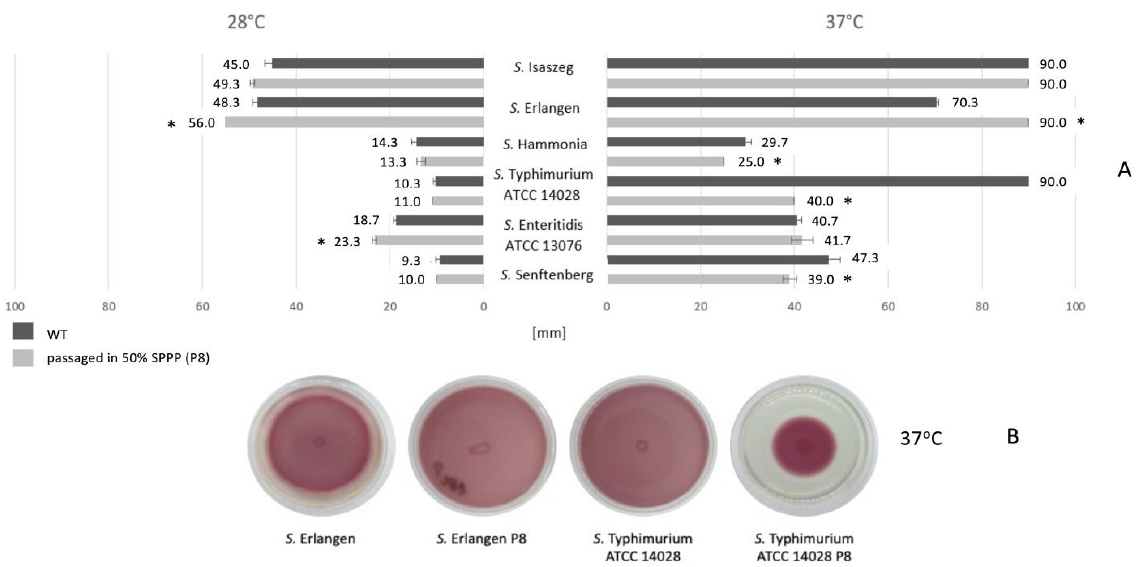
Figure 8. Swimming motility assay. Definitions of abbreviations: ( A ) — the average (n = 3) diameter of bacterial cultures (WT and P8) grown on 0.3% soft agar supplemented with TTC at 28 °C and 37 °C. ( B ) — differences between inoculum growth of pairs S . Erlangen (SS)/ S . Erlangen P8 (SR) and S. Typhimurium ATCC 14028 (SS)/ S. Typhimurium ATCC 14028 P8 (SS); WT — wild-type strain (SS), P8 — strain passaged eight times in 50% SPPP; * indicates a statistically significant difference in values ( p < 0.05) with respect to the WT strains, SS — serum sensitive, SR — serum resistant.